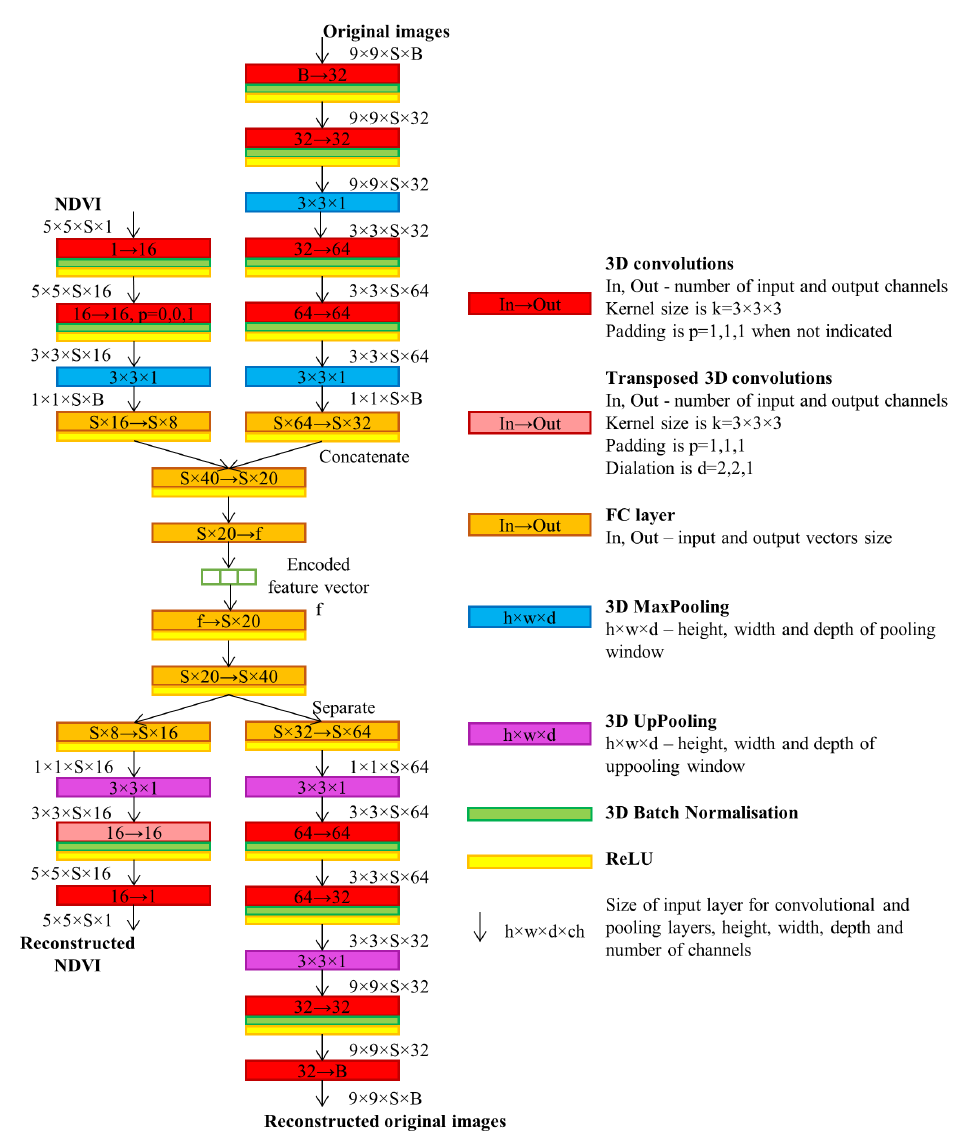
Figure 1. 3D convolutional autoencoder